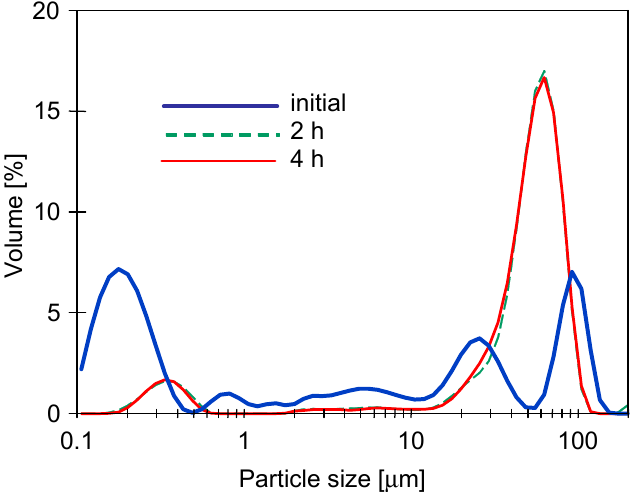
Figure 11. Changes in particle size in the white+wax mixture during the UF process.